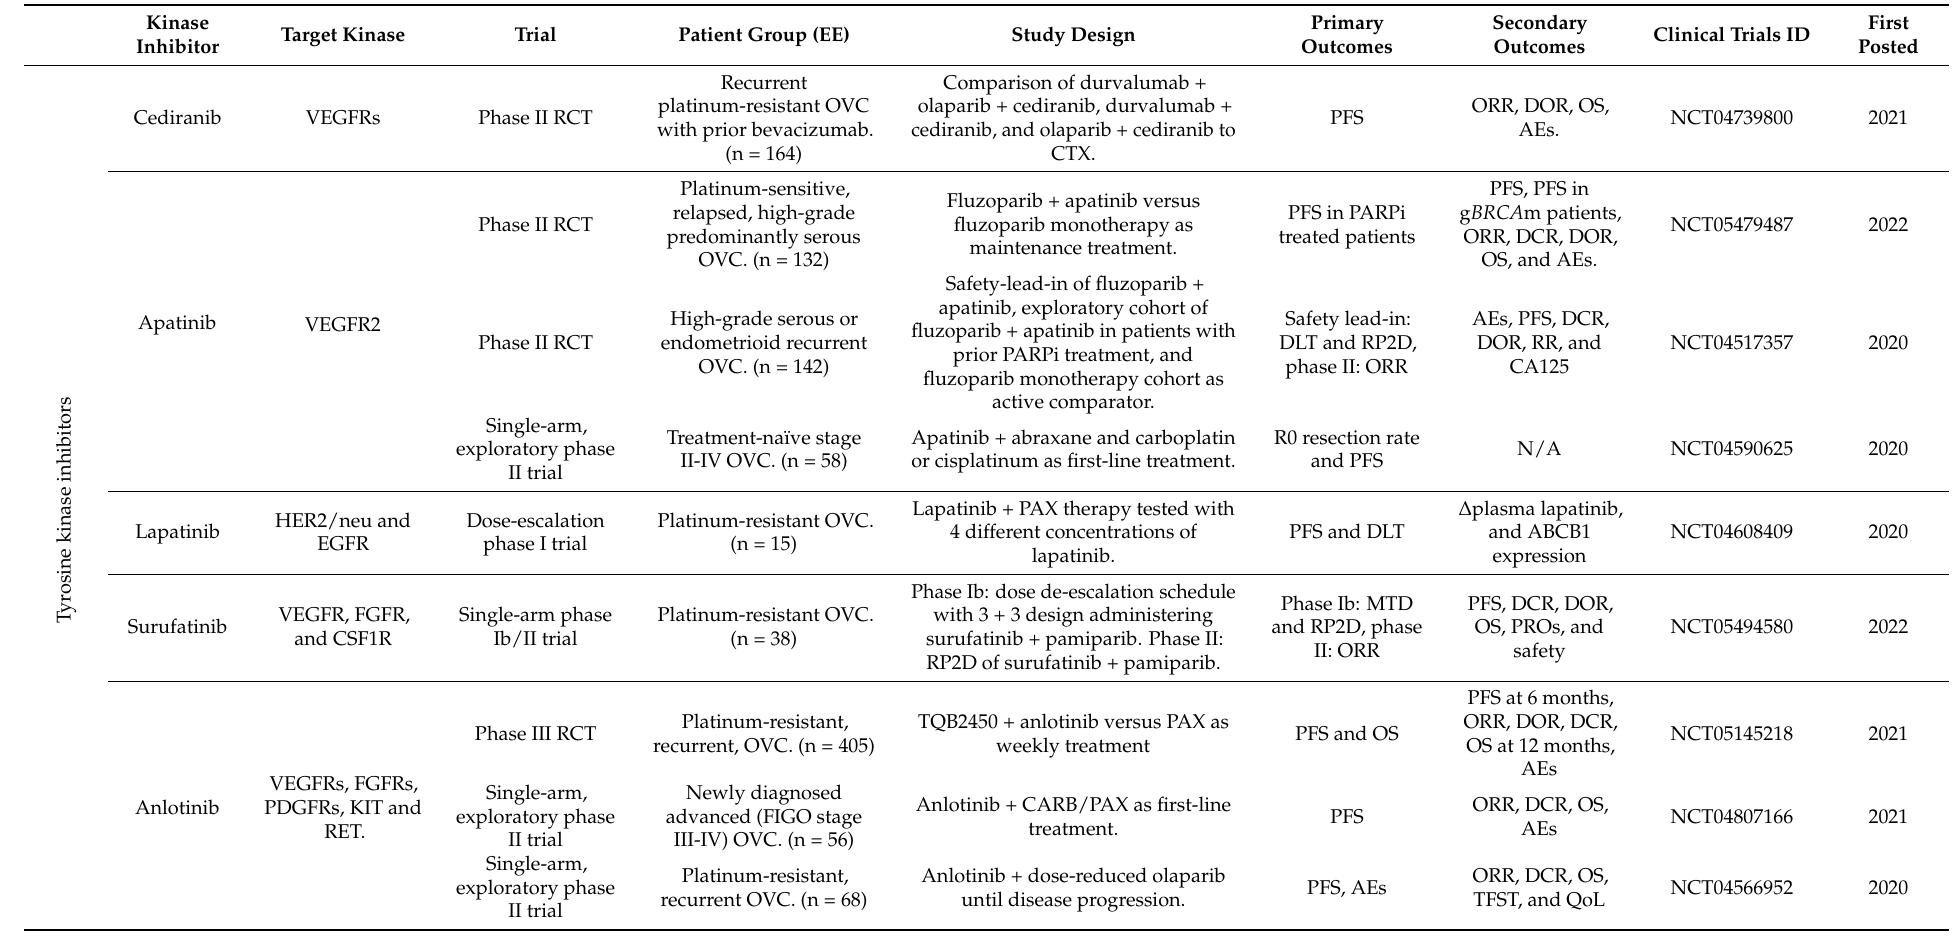
Table 2. Recent, ongoing clinical trials with kinase inhibitor treatment of ovarian cancer first posted on ClinicalTrials.gov in 2020 or